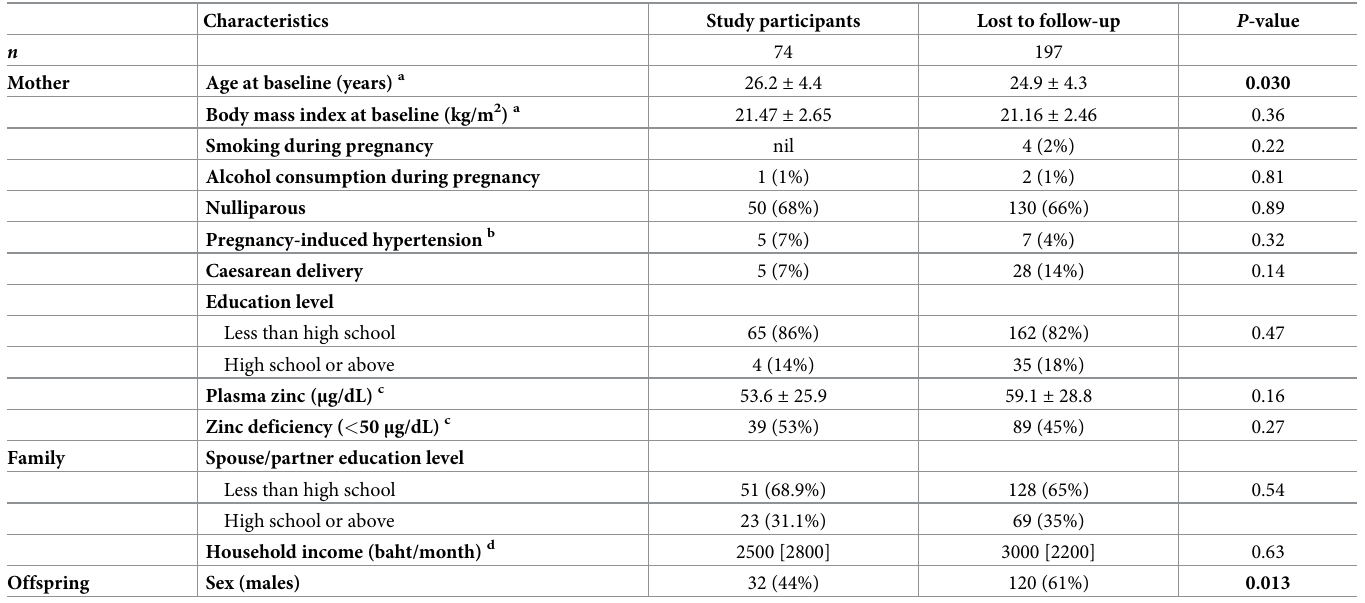
Table 2. Comparison of demographic and birth characteristics between our follow-up study participants and those lost to follow-up. Characteristics